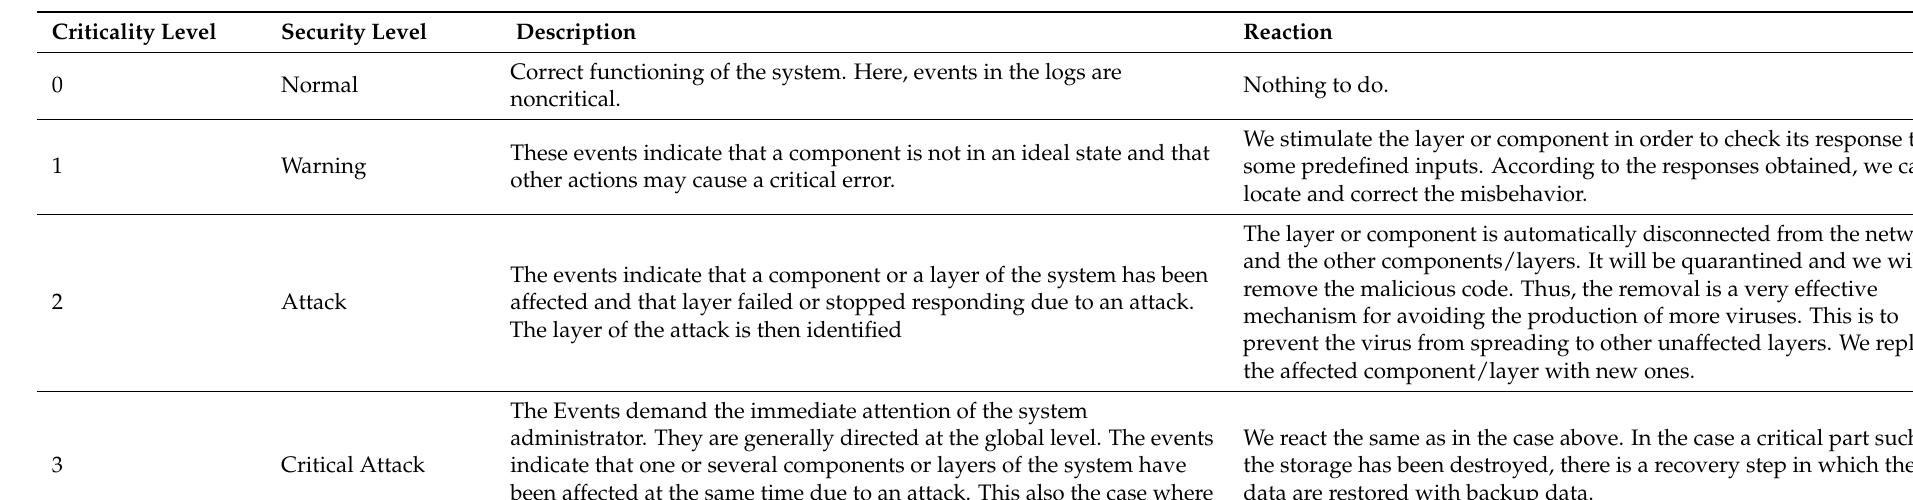
Table 4. The security